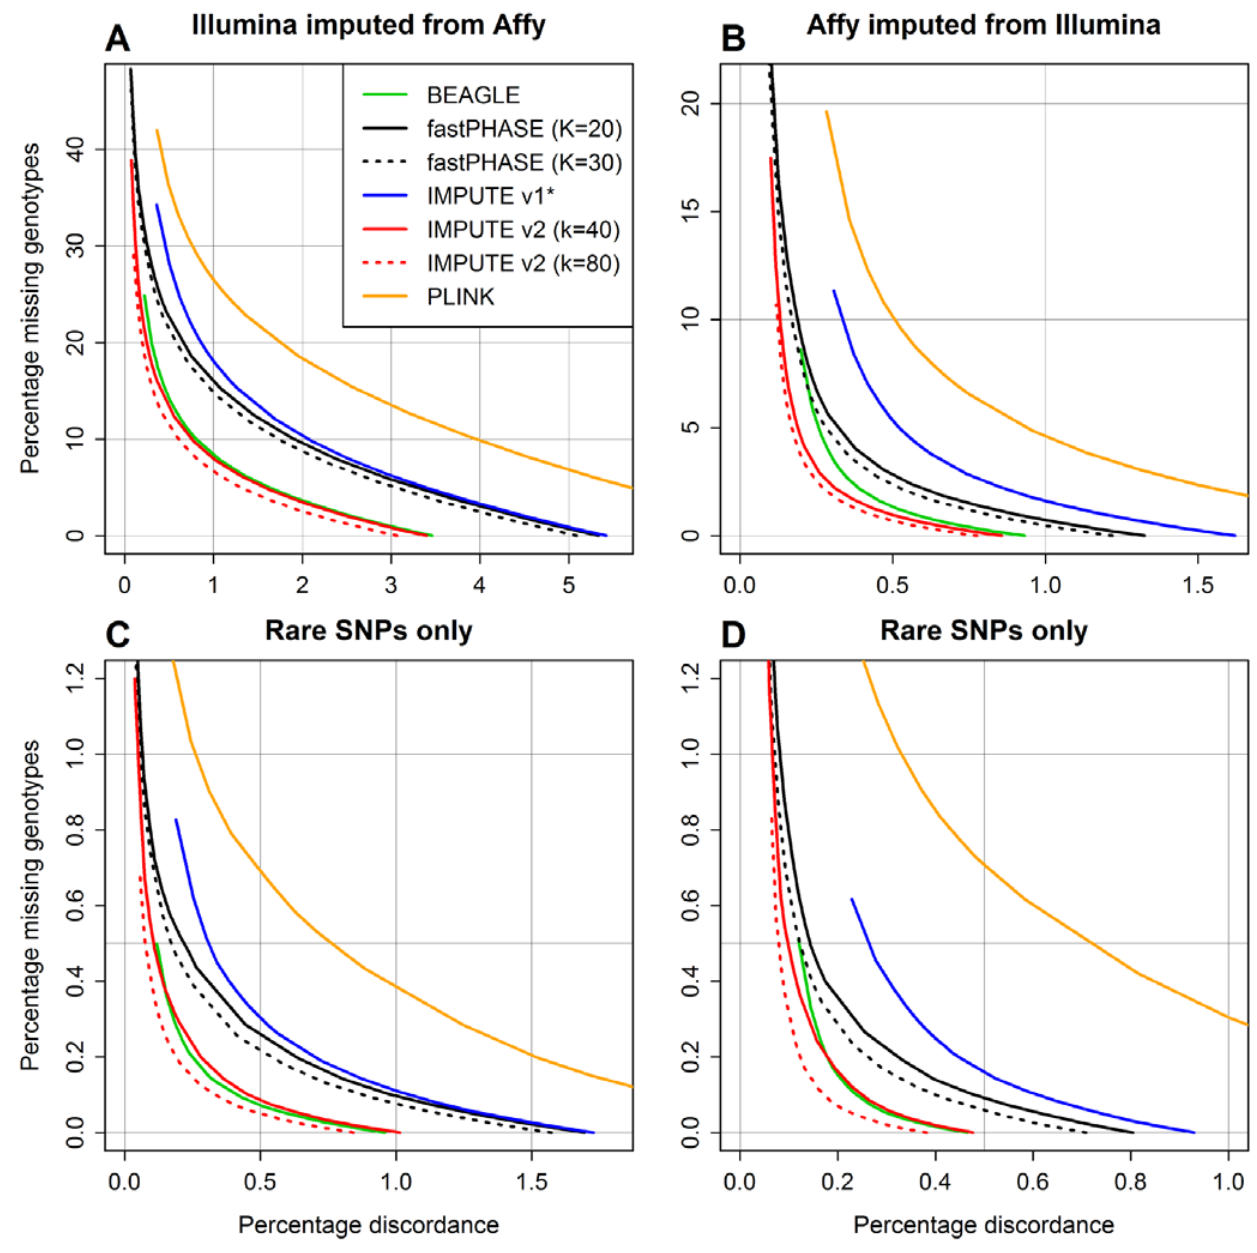
Figure 4. Percentage discordance versus percentage missing genotypes for restricted Scenario B dataset. (A) Results for masked Illumina genotypes imputed from Affymetrix genotypes in the study sample. (B) Results for masked Affymetrix genotypes imputed from Illumina genotypes in the study sample. (C) Results for masked Illumina genotypes (SNPs with MAF , 5% only) imputed from Affymetrix genotypes in the study sample. (D) Results for masked Affymetrix genotypes (SNPs with MAF , 5% only) imputed from Illumina genotypes in the study sample. four curves in each panel: IMPUTE v2 in the full Scenario B dataset discordances based on Illumina genotypes (Figure 4D) were 0.48% ( k =40; dashed red line); BEAGLE in the full dataset (default (IMPUTE v2, k = 40), 0.38% (IMPUTE v2, k = 80), and 0.46% settings; dashed green line); BEAGLE in the restricted dataset (BEAGLE), as compared to 0.93% for IMPUTE v1. (default settings; solid green line); and IMPUTE v1 in the restricted Accuracy comparison on full dataset. The results of our dataset (solid blue line). The first two curves (dashed lines) are the main focus of this comparison, and the latter two curves (solid lines) are carried over from Figure 4 for reference.